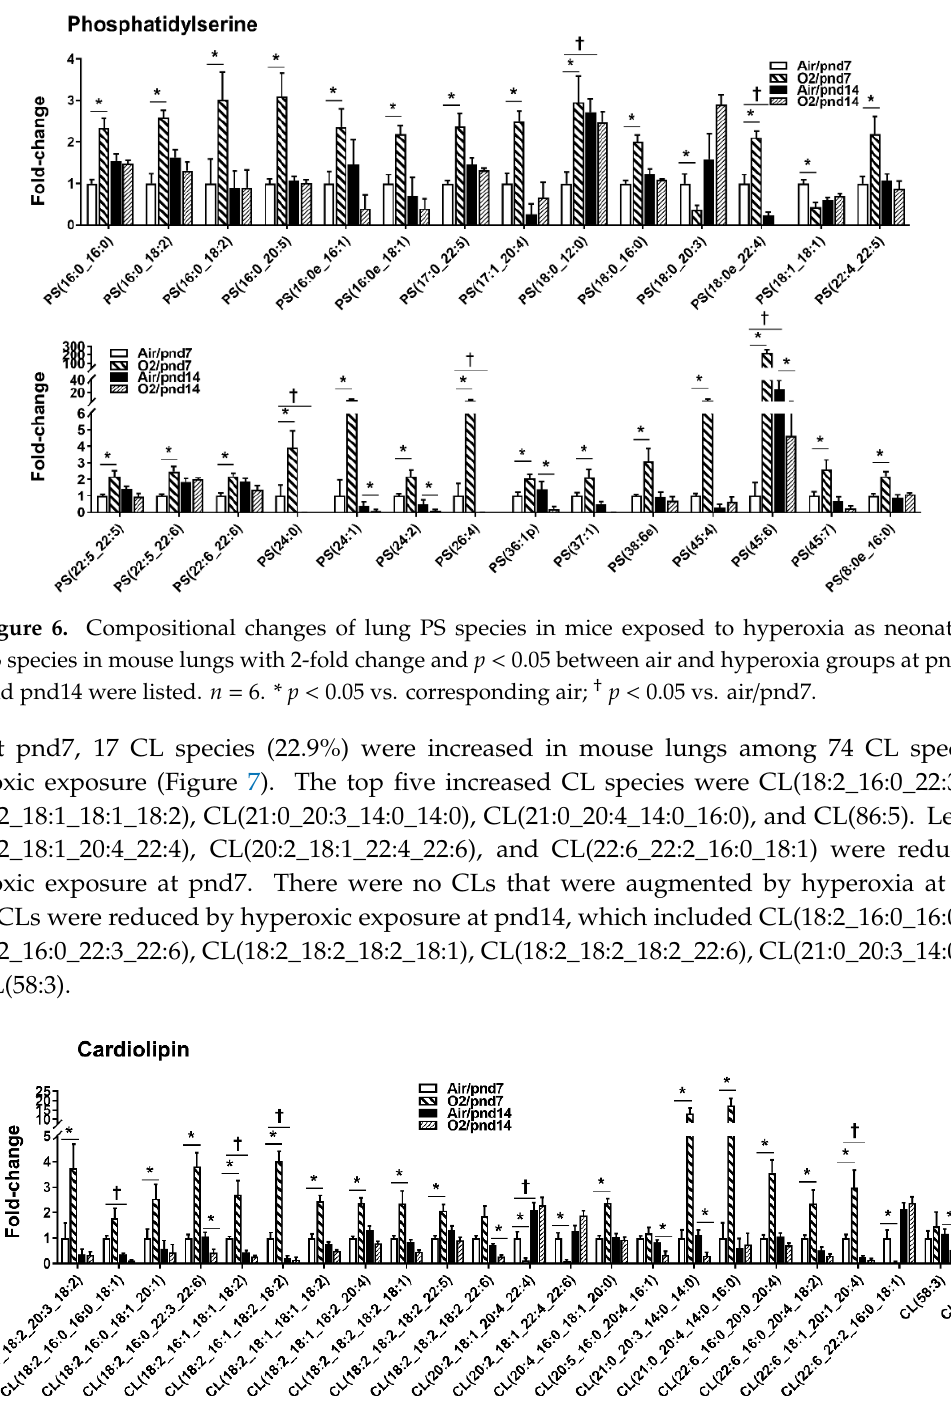
Figure 7. Compositional changes of lung CL species in mice exposed to hyperoxia as neonates. CL species in mouse lungs with 2-fold change and p < 0.05 between air and hyperoxia groups at pnd7 and pnd14 were listed. n = 6. * p < 0.05 vs. corresponding air; † p < 0.05 vs. air/pnd7 .